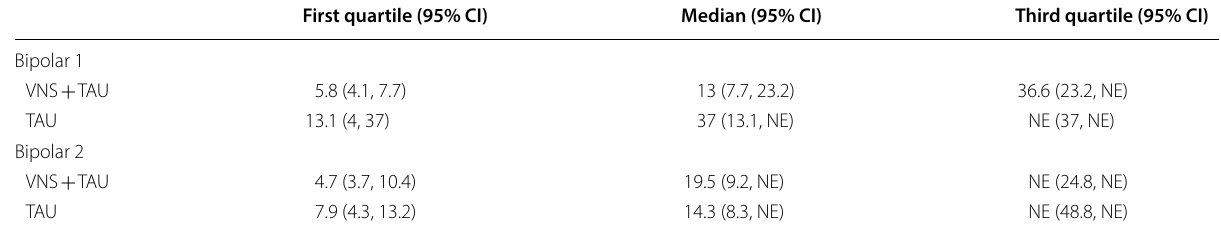
CI confidence interval, NE not